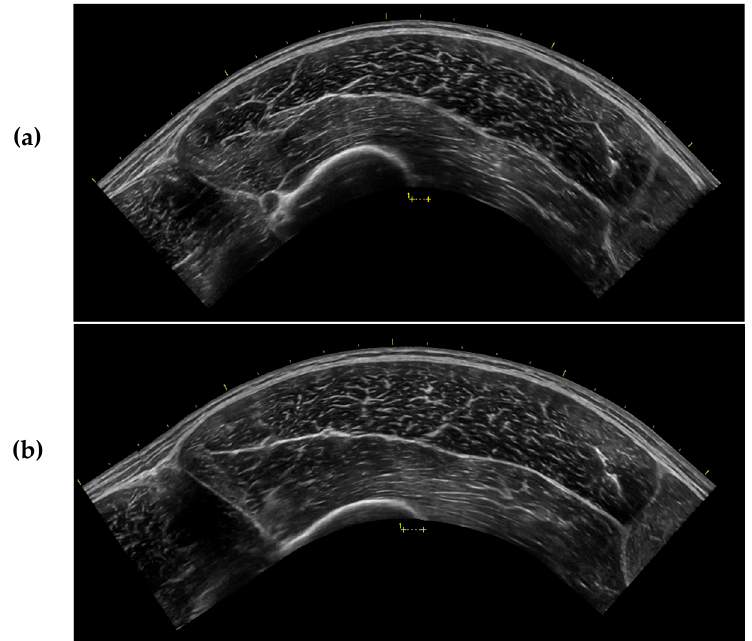
Figure 3. Sample ultrasound images captured from the same participant after 15 min of rest in ( a ) the supine position (SUP) and ( b ) during standing (ST). All ultrasound settings were kept consistent throughout testing for each participant.